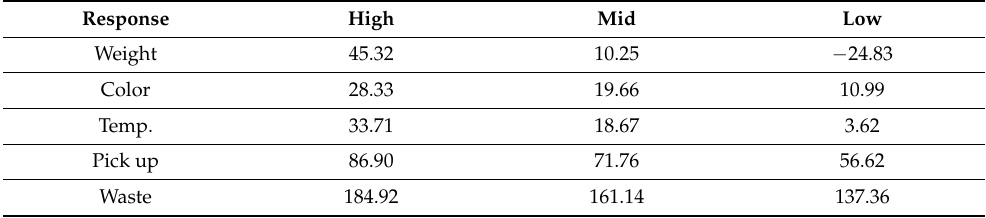
Table 10. The largest and smallest values in High, Mid and Low MFs of SNR for each